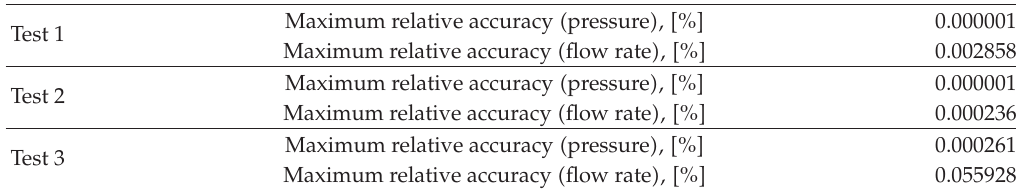
Table 5: The worst results after Stage 1 of the test